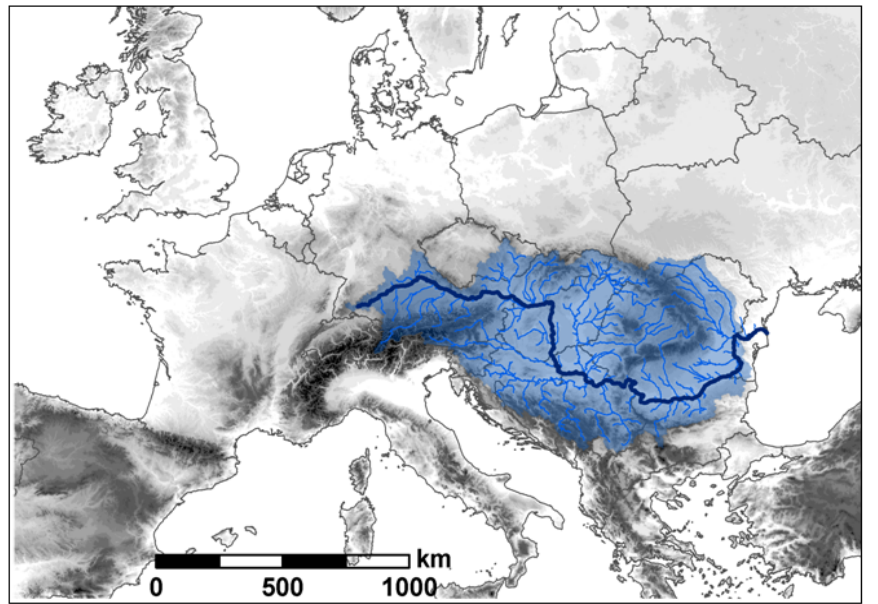
Figure 1. Study area: the Danube River catchment in Europe.